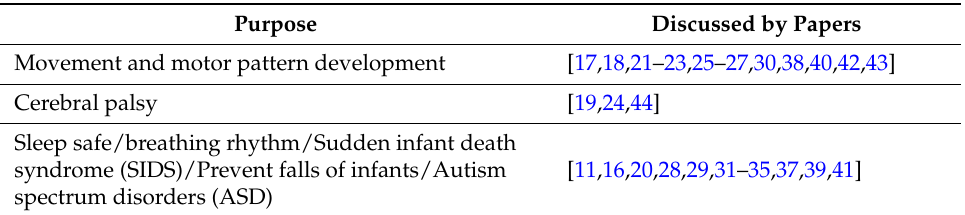
Table 4. Statistical representation of research purpose of infant movement monitoring.